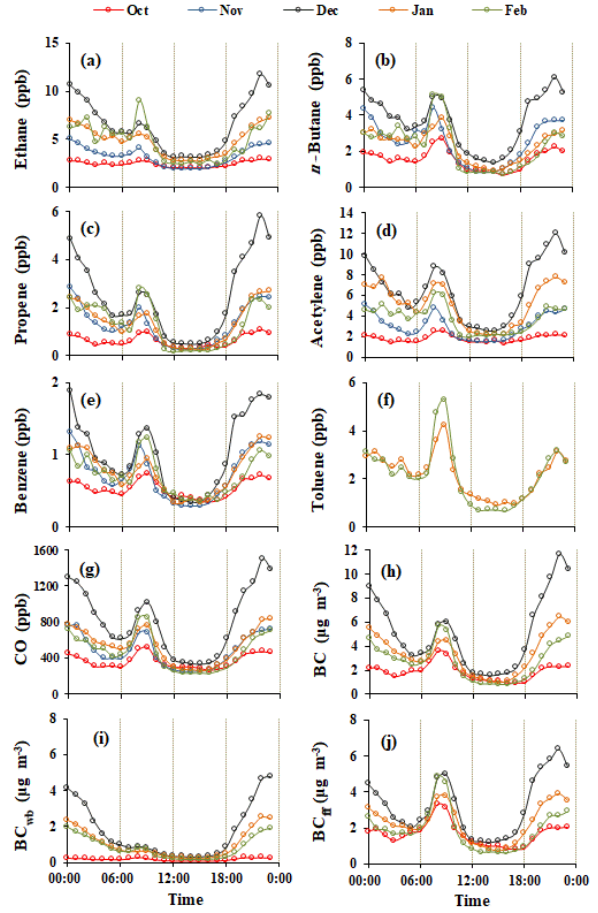
Figure 4. Monthly diurnal variability of (a) ethane, (b) n- butane, (c) propene, (d) acetylene, (e) benzene, (f) toluene, (g) CO, (h) BC, (i) BC wb and (j) BC ff based on hourly averaged